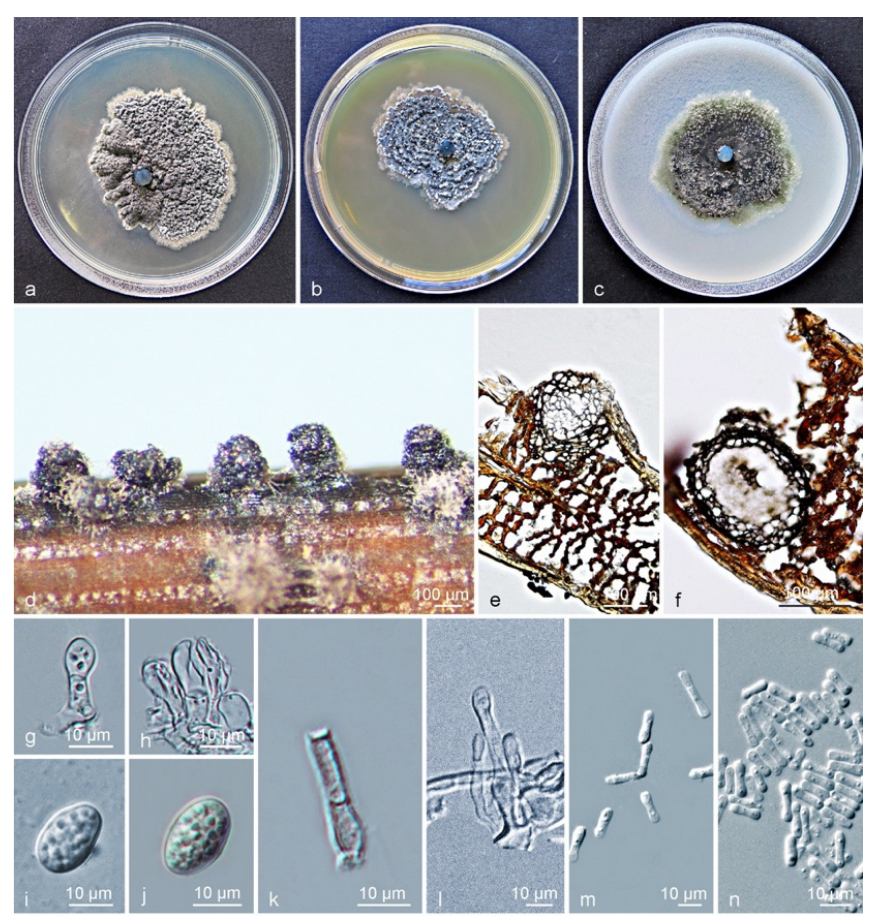
Figure 4. Characteristics of Phyllosticta citrichinaensis subclade II. ( a – c ) Living culture after 10 d on PDA, MEA, and OA (front). ( d ) Conidiomata formed on pine needle agar; ( e , f ) longitudinal section through conidiomata; ( g , h ) conidiogenous cells and developing conidia; ( i , j ) conidia with mucoid sheaths and apical appendages; ( k , l ) spermatial cells giving rise to spermatia; ( m , n ) spermatia. Scale bars: ( d – f ) = 100 µm; ( g – n ) = 10 µm.